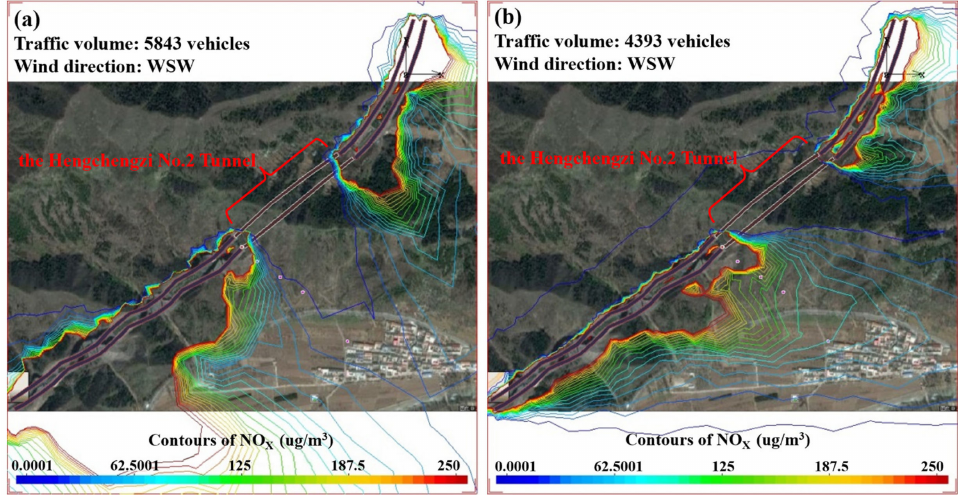
Figure 6. Hourly average concentration distribution of NO X at a peak period in the Hengchengzi No.